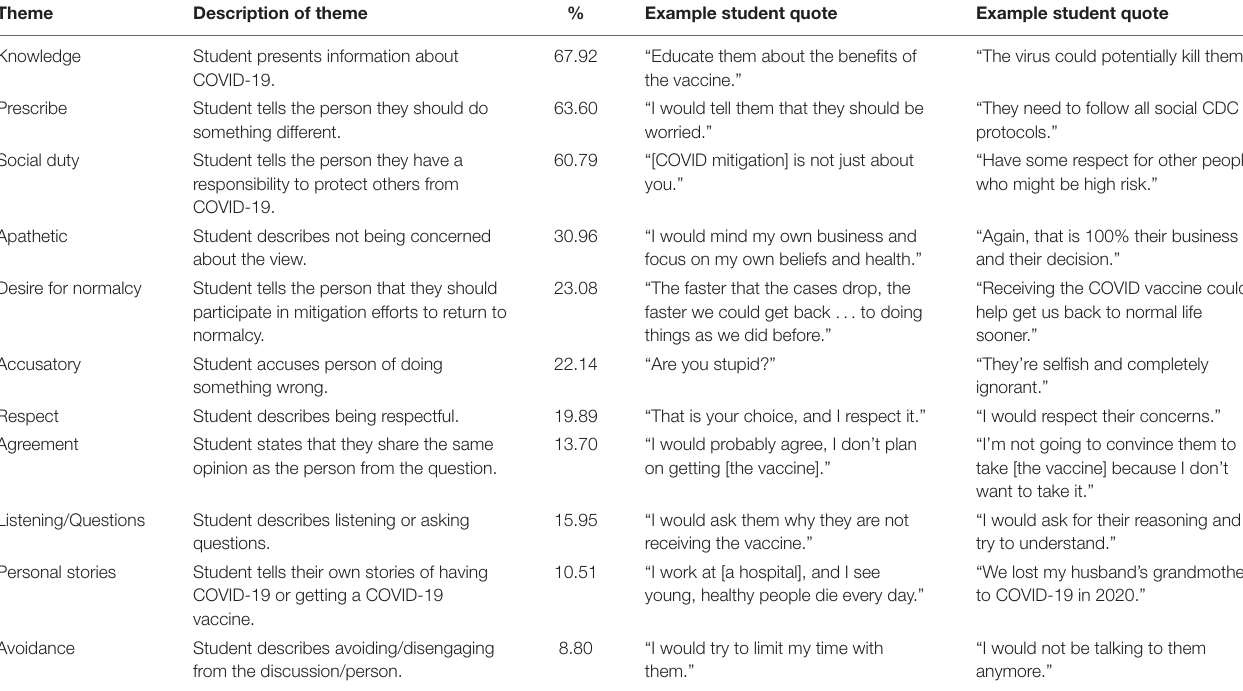
TABLE 2 | Themes in students’ written responses when they were asked how they would communicate with a friend or family member who was not concerned about COVID-19, did not intend to wear a mask, or had hesitations or concerns about the COVID-19 vaccine.